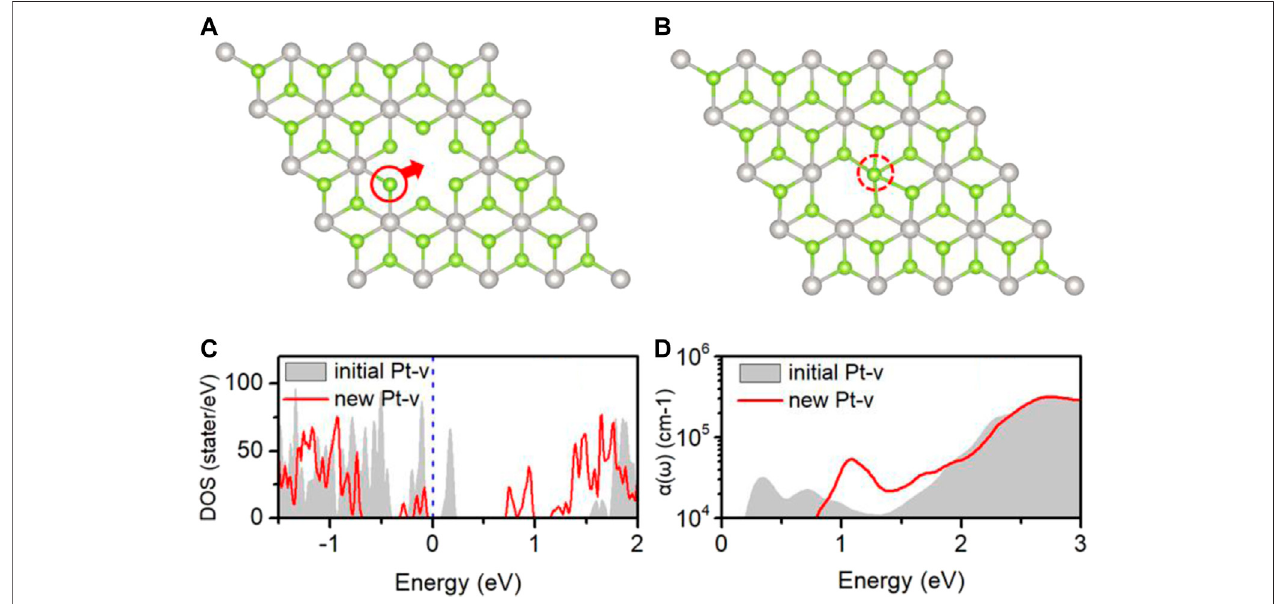
FIGURE 6 | (A) Local atomic structures of the initial (A) and new (B) Pt-v defects; the DOS (C) and optical absorption coef fi cient (D) of PtSe 2 with the initial Pt-v defect (gray areas) and new Pt-v defect (red lines). The Fermi levels (blue dashed line) are set to 0 eV.